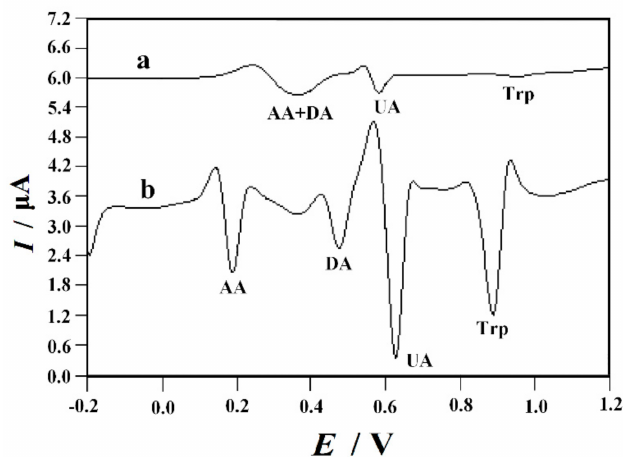
Figure 9. SDLSVs obtainedat the ( a ) bare GCE and ( b ) PVP-GR / GCE in the presence of 0.5 mM ascorbic acid (AA), 50 µ M dopamine (DA), 10 µ M uric acid (UA) and 10 µ M Trp. Other conditions are the same as in Figure